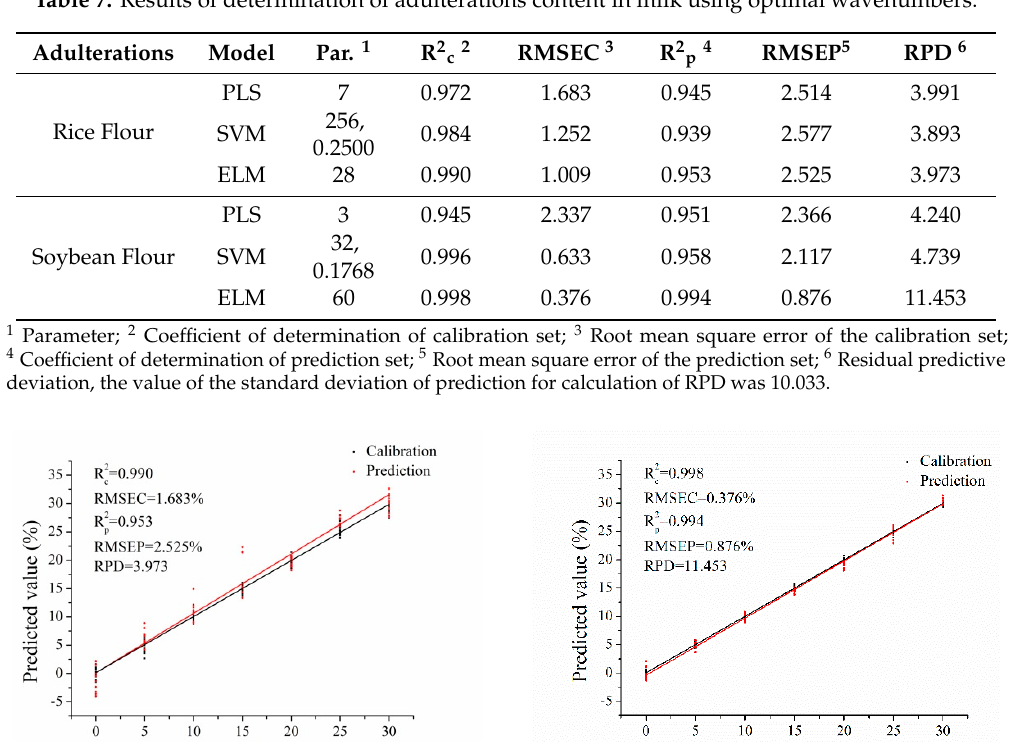
Table 7. Results of determination of adulterations content in milk using optimal wavenumbers.